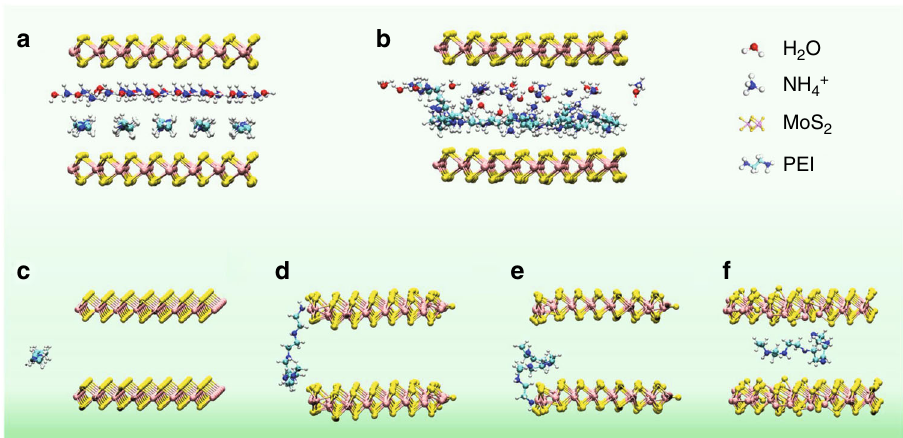
Fig. 3 Molecular dynamics calculations. a , b Schematic illustration shows con fi gurations of PEI-intercalated MoS 2 with the resulted interlayer distance of 10.8 Å: a an initial ordered state; b the fi nal relaxed state. c – f Illustration of PEI molecule intercalation process with the MoS 2 interlayer distance of 10 Å: c 0 ps, d 4 ps, e 6 ps, f 7